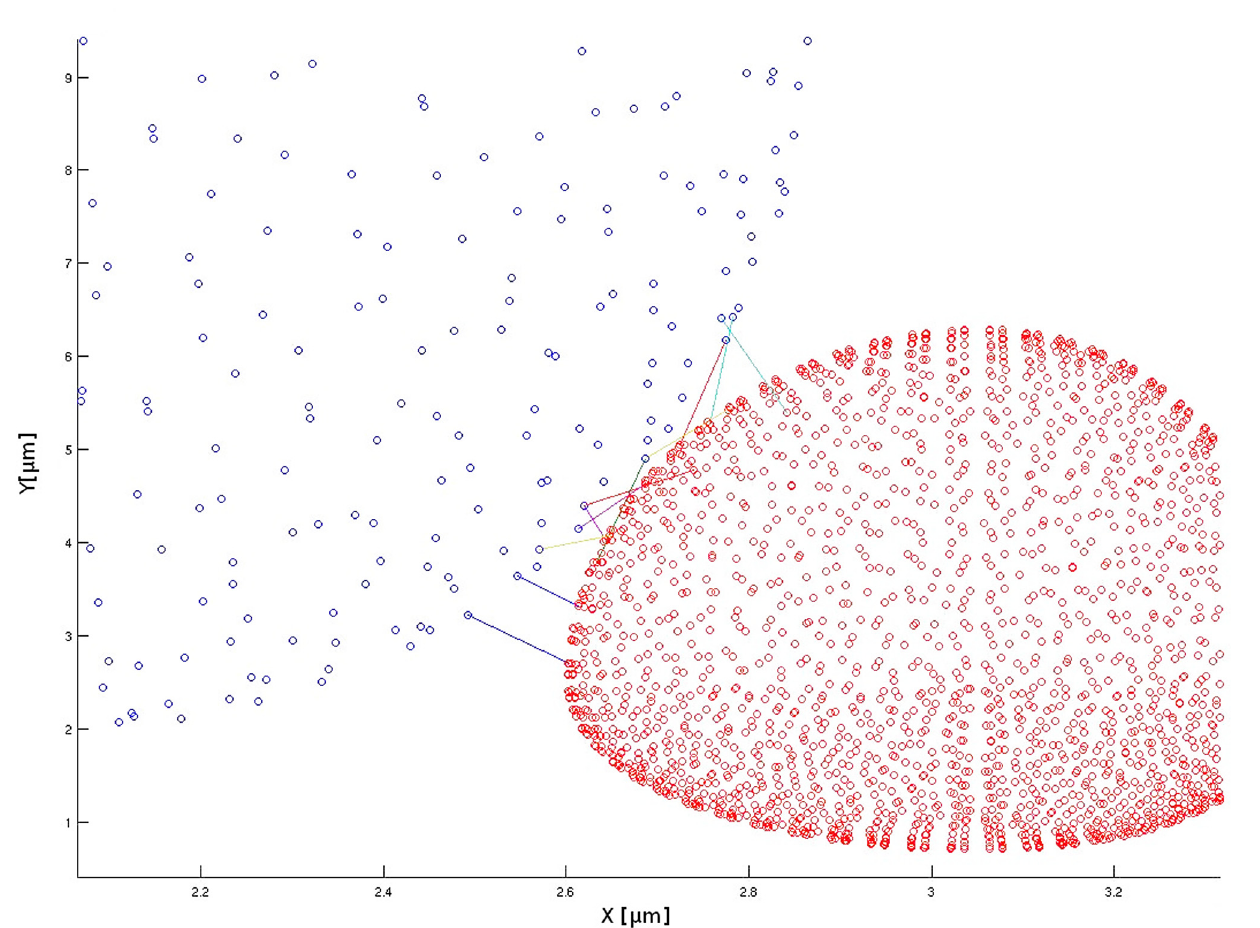
Fig 7. Zoomed view of bond formation using the coarse computational mesh. This is a zoomed view of the bond formation and 3D point clouds of the PMN and melanoma cell using the coarse mesh. With the coarse computational mesh, 97 bonds were formed and are shown. Each face pair contains multiple adhesive bonds, which allows for an appropriate number interactions although fewer computational faces are involved in the calculations. Note: multiple bonds may occur between the same face